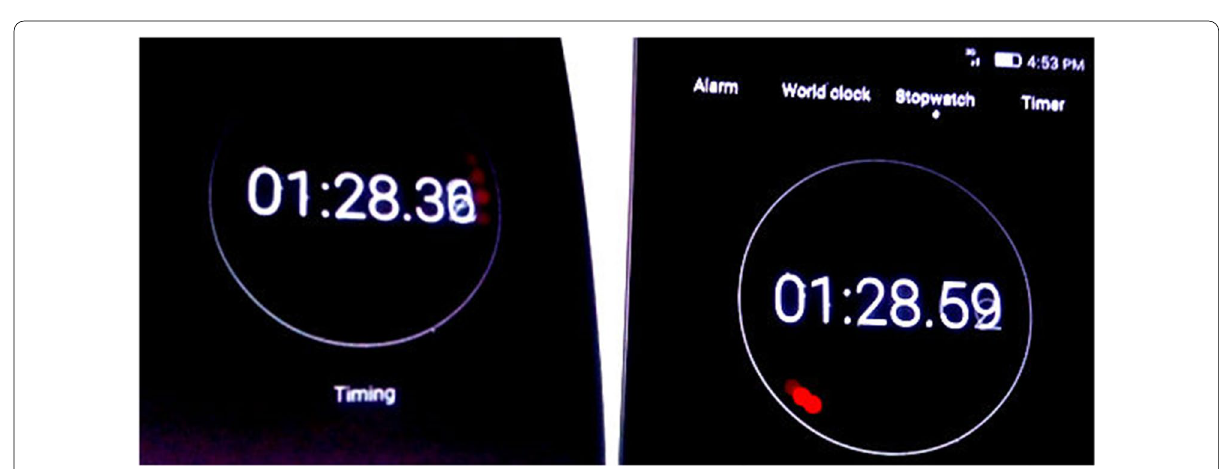
Fig. 4 Near real-time wireless video transmission with a virtually imperceptible latency of 200 ms. Left above is photograph of mobile phone stopwatch, and right image is photograph of computer monitor with wireless transmission from